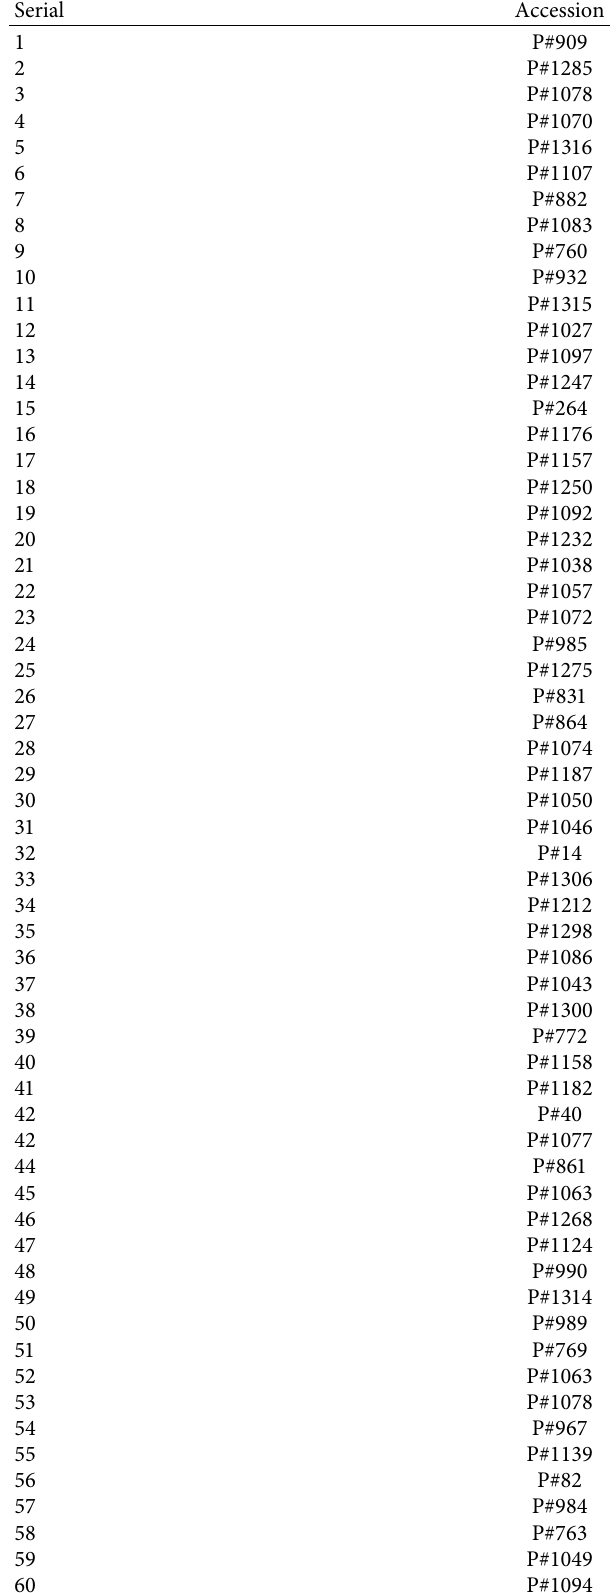
Table 1: List of landrace accessions used in the